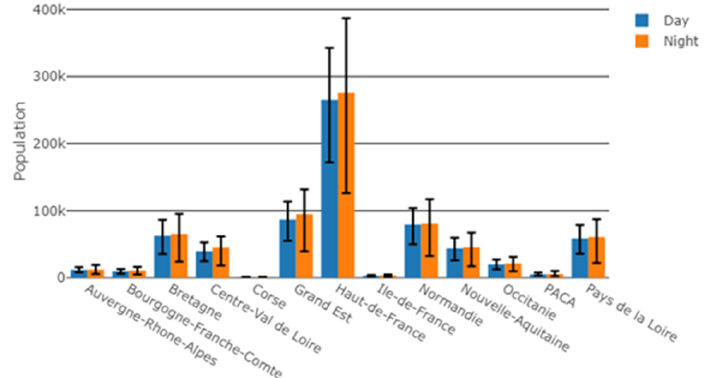
Figure 6. Number of people exposed to WT sound level above 30 dBA, by region. Error bars account for the uncertainty of +/ − 1 standard deviation on the Harmonoise sound level estimate.